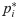
Contour plot of the convergence time t* in Eq (6) as a function of the production function parameter α and the participation load pi*, when only one individual participates in the task completion process.In this scenario, lower values of αi are associated with smaller convergence times t*.